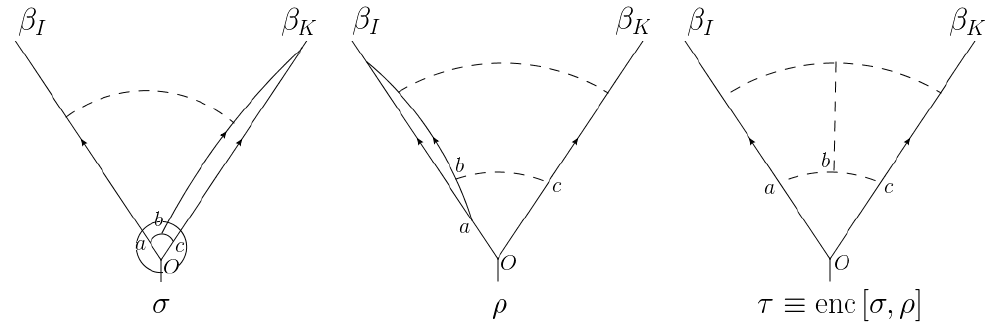
Figure 39. An example of (cid:27) , (cid:26) , and (cid:28) (cid:17) enc [ (cid:27); (cid:26)